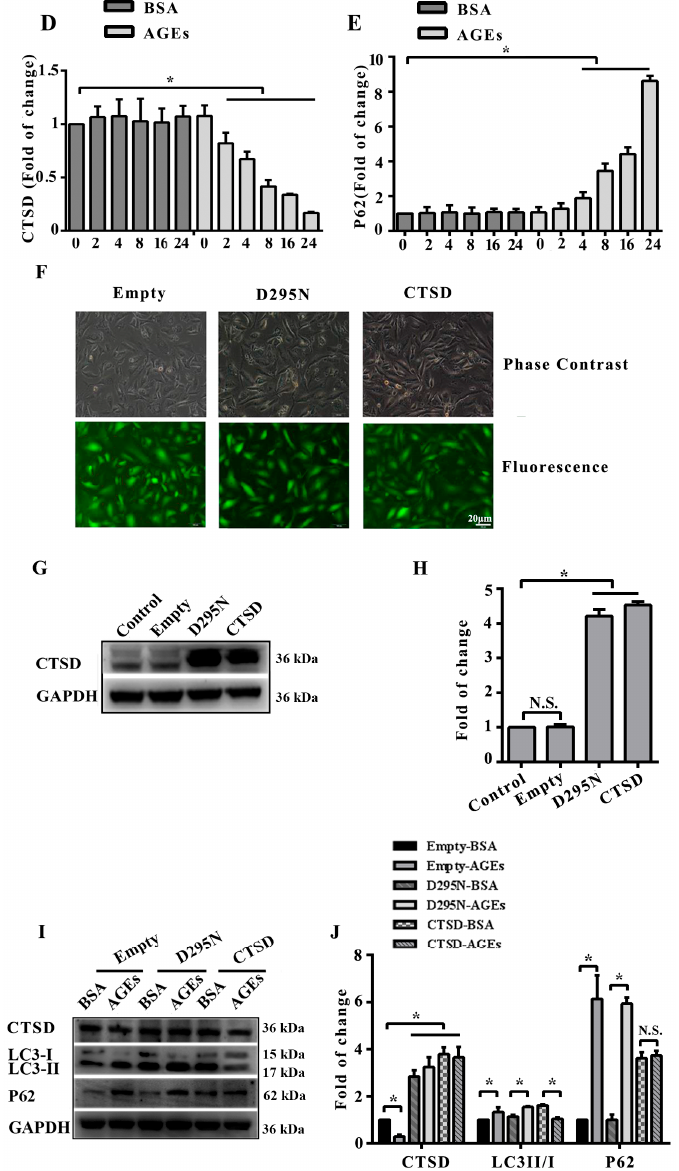
Figure 4. Cathepsin D (CTSD) was implicated in autophagic flux mediated by AGEs in HUVECs. CTSD was overexpressed in HUVECs using lentiviral vectors labelled with GFP. ( A ) Cells were treated with 100 µg/mL AGEs and 10 µg/mL BSA for 24 h. The protein expression of LC3-II, LC3-I, p62, and CTSD were analyzed using western blotting, and GAPDH was used as a control; ( B ) The band intensity was quantified using Image J 1.47, normalized by GAPDH (* p < 0.05 vs. BSA group); ( C ) Cells were treated with 100 µg/mL AGEs and 10 µg/mL BSA for different times (0, 2, 4, 8, 16 and 24 h). The expression of p62 and CTSD were analyzed using western blotting, and GAPDH was used as a control; ( D , E ) The band intensity was quantified using Image J 1.47, normalized by GAPDH (* p < 0.05 vs. BSA group at 0 h); ( F ) CTSD was successfully transfected into cells. Green cells were labelled with green fluorescent protein, which indicated the transfection was successful; ( G ) The protein expression of CTSD was analyzed by western blotting; ( H ) The band intensity was quantified using Image J 1.47, normalized by GAPDH (* p < 0.05 vs. normal control. N.S., no statistical significance.); ( I ) The protein expression of LC3-II, LC3-I, p62, and CTSD were analyzed using western blotting after CTSD was transfected into cells; ( J ) The band intensity was quantified using Image J 1.47, normalized by GAPDH (* p < 0.05 vs. empty-BSA group. N.S., no statistical significance.). All data were obtained from reproducible experiments ( n = 3).